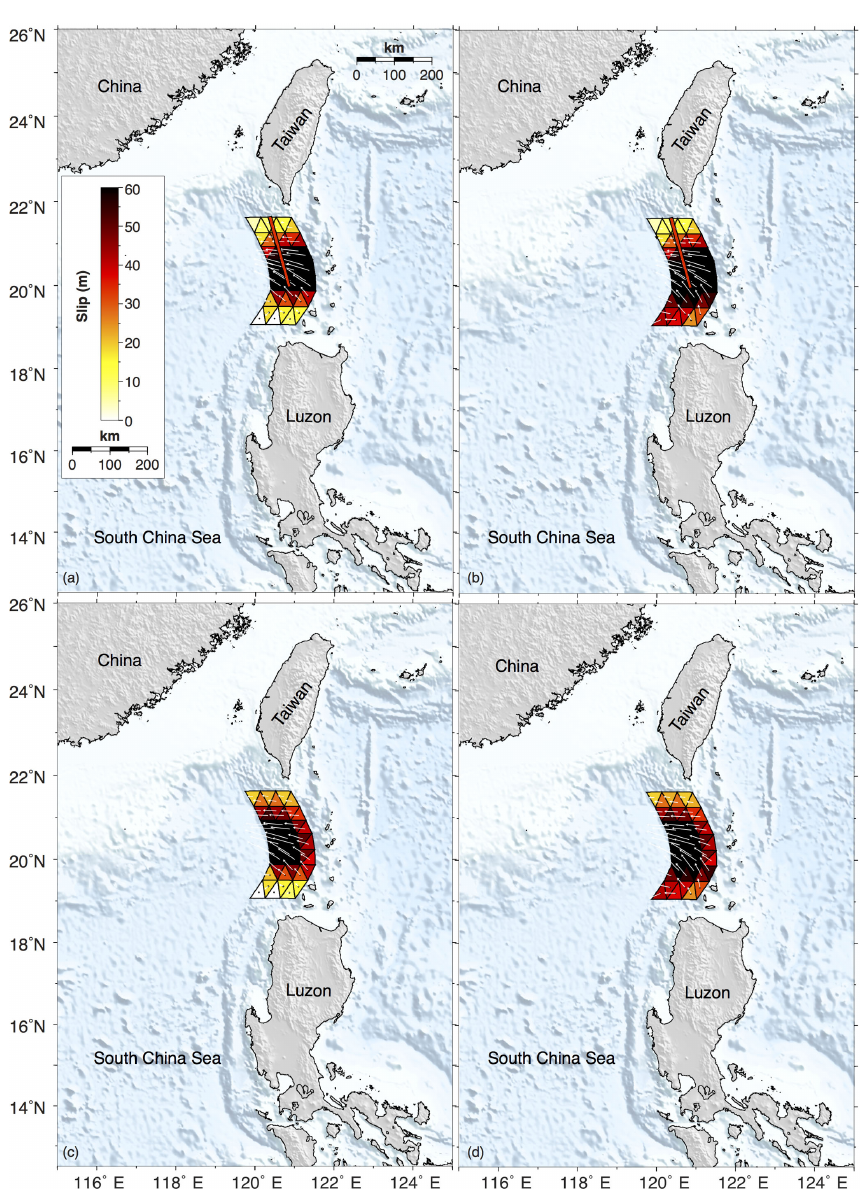
Figure 6. (a) Seismogenic megathrust rupture together with megasplay rupture scenario with 80% coupling ratio for each of them from model A of Hsu et al. (2016). Panel (b) same as (a) but from model B of Hsu et al. (2016). (c) Shallow rupture (e.g., Tohoku-Oki rupture) the same as Fig. 3a but with 80% coupling ratio on the megathrust. (d) Shallow rupture (e.g., Tohoku-Oki rupture) same as Fig. 3b but with 80% coupling ratio on the megathrust. A 1000-year seismic return period was assumed in the slip calculation.